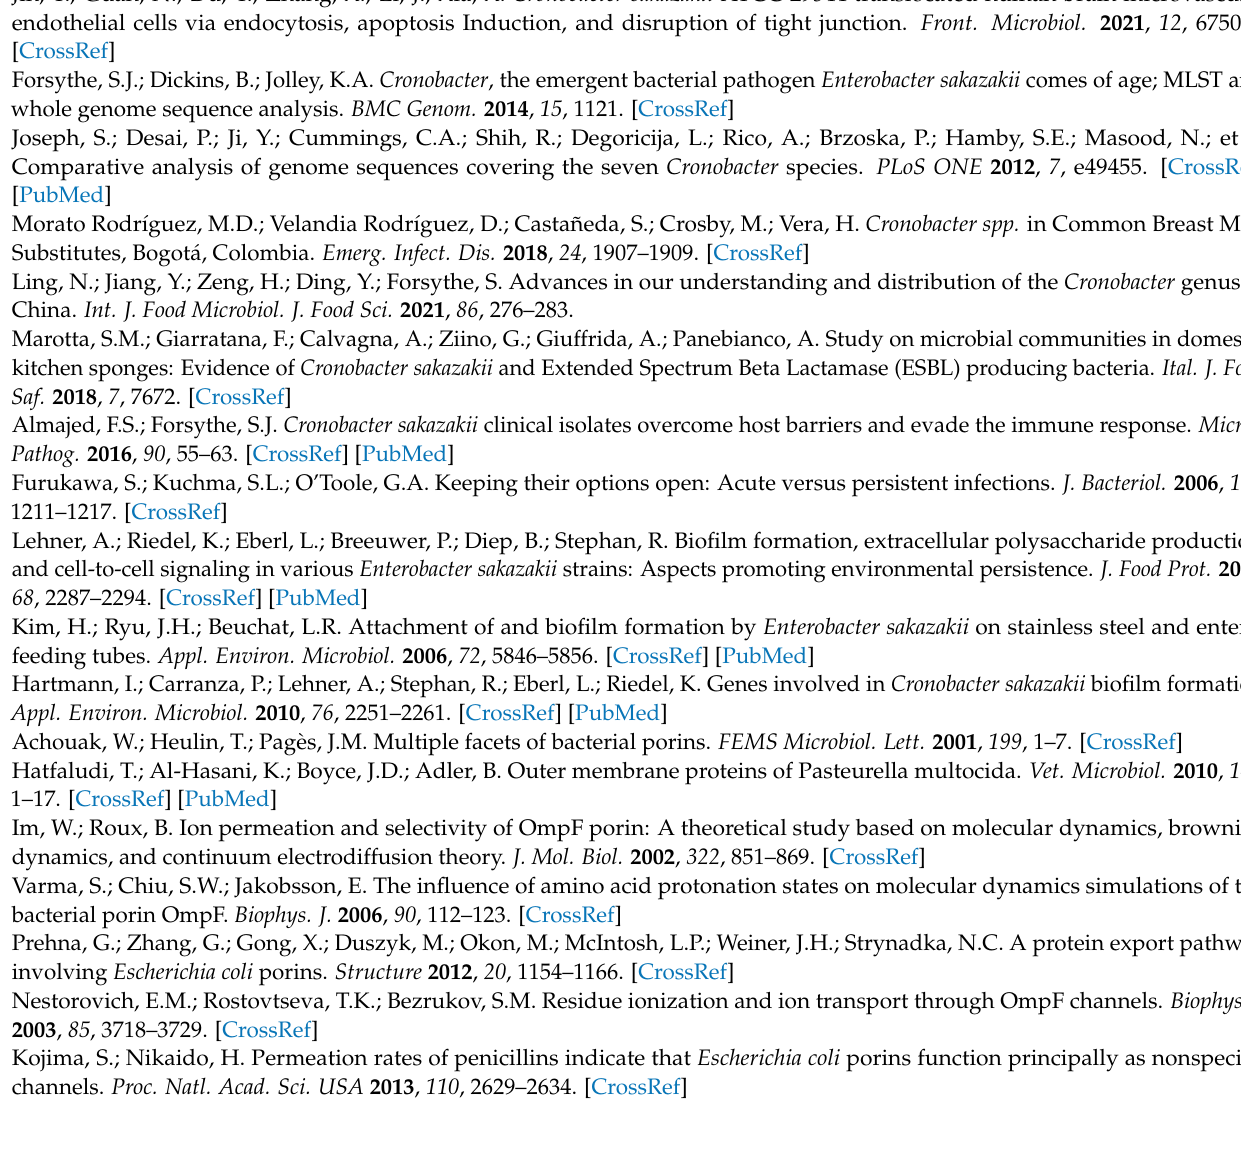
Table S2. Primers used in this study, Table S3. Raman intensities of different